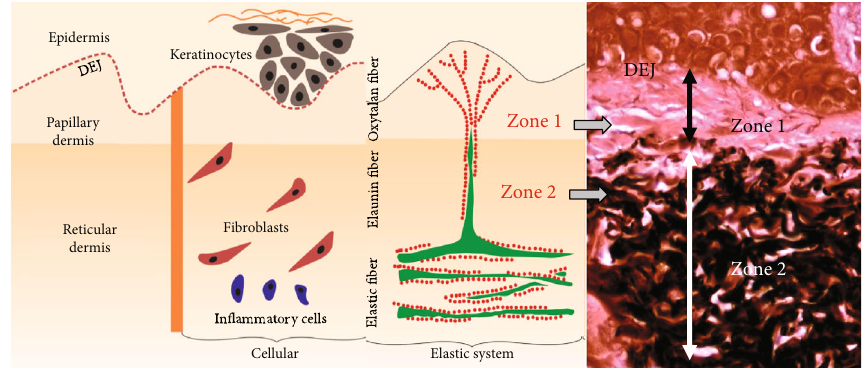
Figure 2: De fi nition of zones 1 and 2 of the dermis (40x magni fi cation). Zone 1 is de fi ned as an area delimited between the dermoepidermal junction (DEJ) and the presence of elastic material deposited in the deep dermis. Another band (zone 2) has been established which comprises the limits of the elastic material deposited more deeply in the